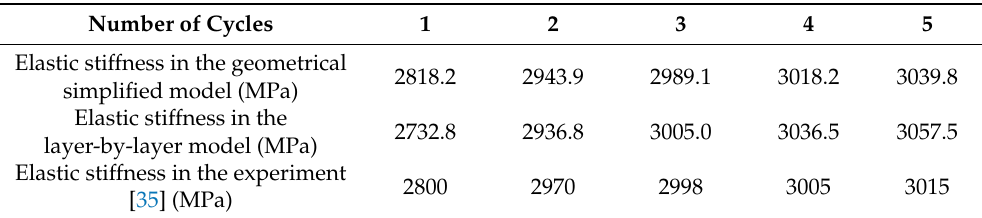
Table 4. Summary of the ES of the geometrical simplified model changes and the layer model changes in the numerical simulation, induced by cyclic compressive loading.